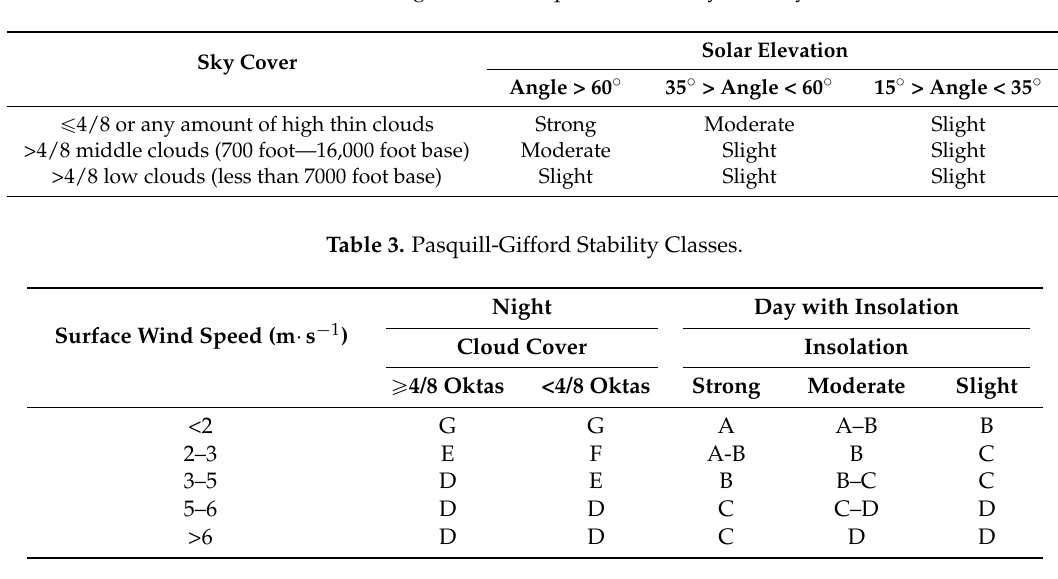
Table 2. Insolation Categories for Pasquill-Gifford Day Stability Classes.